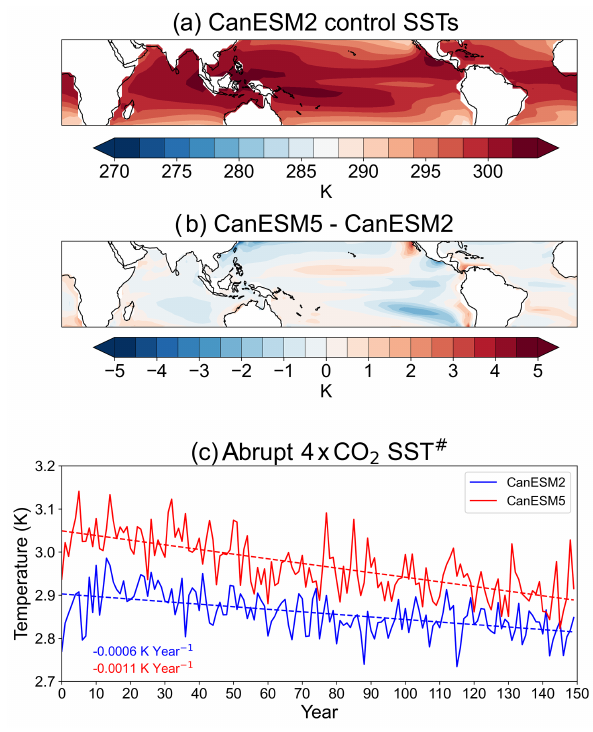
Figure 4. (a) Pre-industrial control mean (150 years) tropical SSTs for CanESM2. (b) Pre-industrial control mean (150 years) tropical SSTs for CanESM5, expressed as a difference relative to CanESM2. (c) Annual mean time series of SST # for both CanESM2 and CanESM5 for abrupt 4 × CO 2